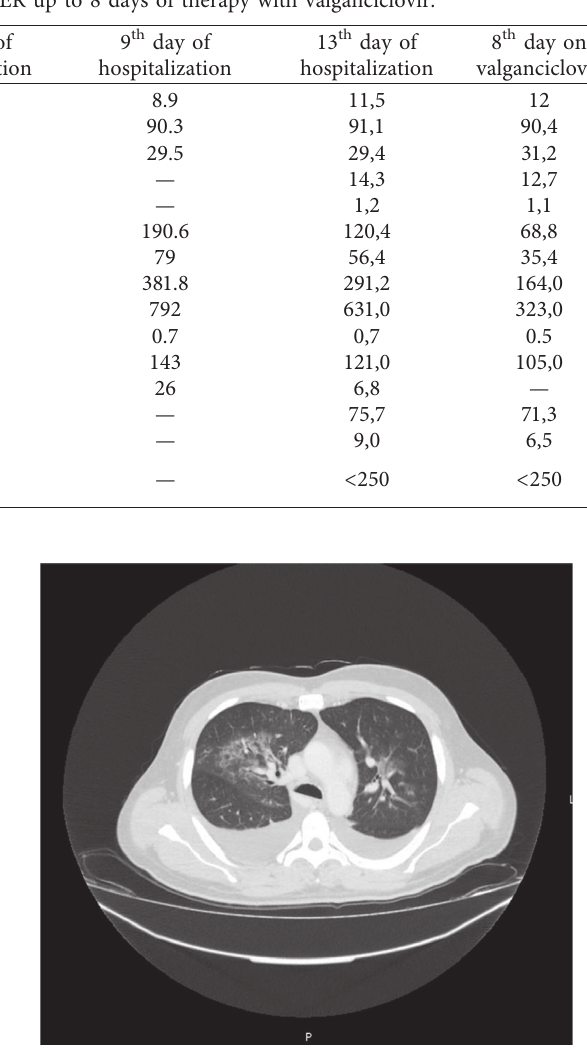
Figure 2: Chest CT with ground glass areas in the left and right pulmonary lobes; bilateral pleural